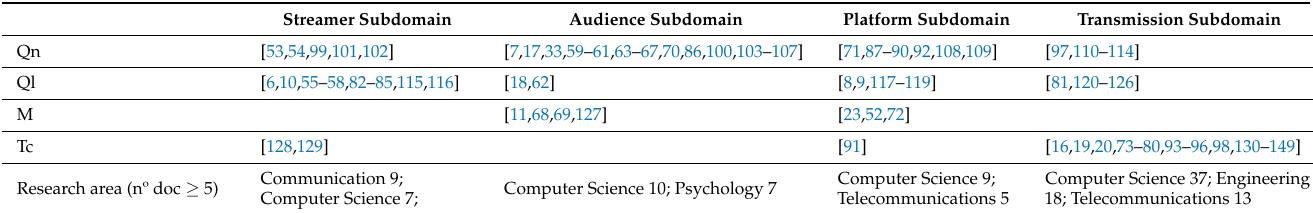
Table 2. Main methodology and research